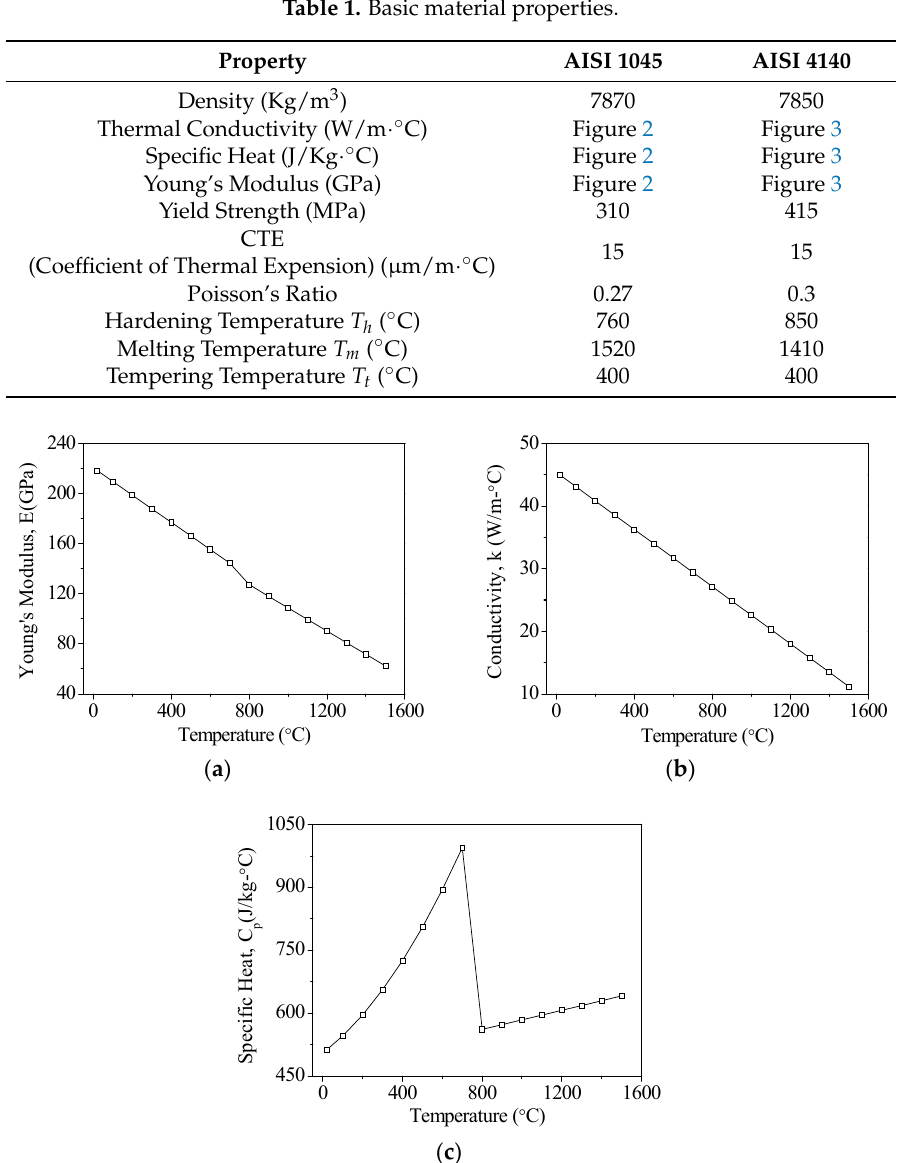
Figure 2. The temperature depenent material properties of AISI 1045. ( a ) Young’s modulus; ( b ) Coefficient of thermal conductivity; and ( c ) Specific